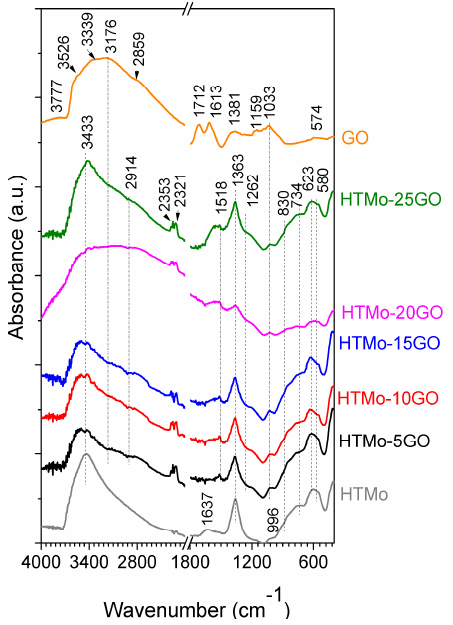
Figure 3. ATR-FTIR sp е ctra of th е hybrid catalysts, compared to neat HTMo and GO.